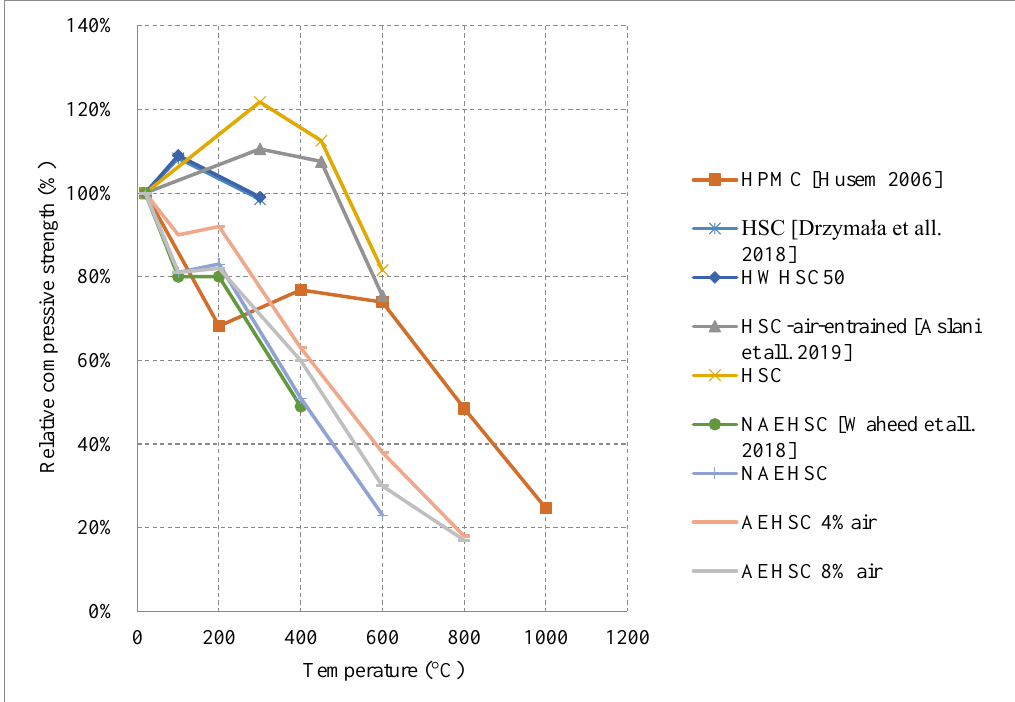
Figure 13. Relative compressive strength of naturally cooled HSC with different constituents. HPMC: High Performance Micro Concrete, HWHSC: Heavy Weight High Strength Concrete, NAEHSC: Non- Air-Entrained High Strength Concrete, AEHSC: Air-Entrained High Strength Concrete